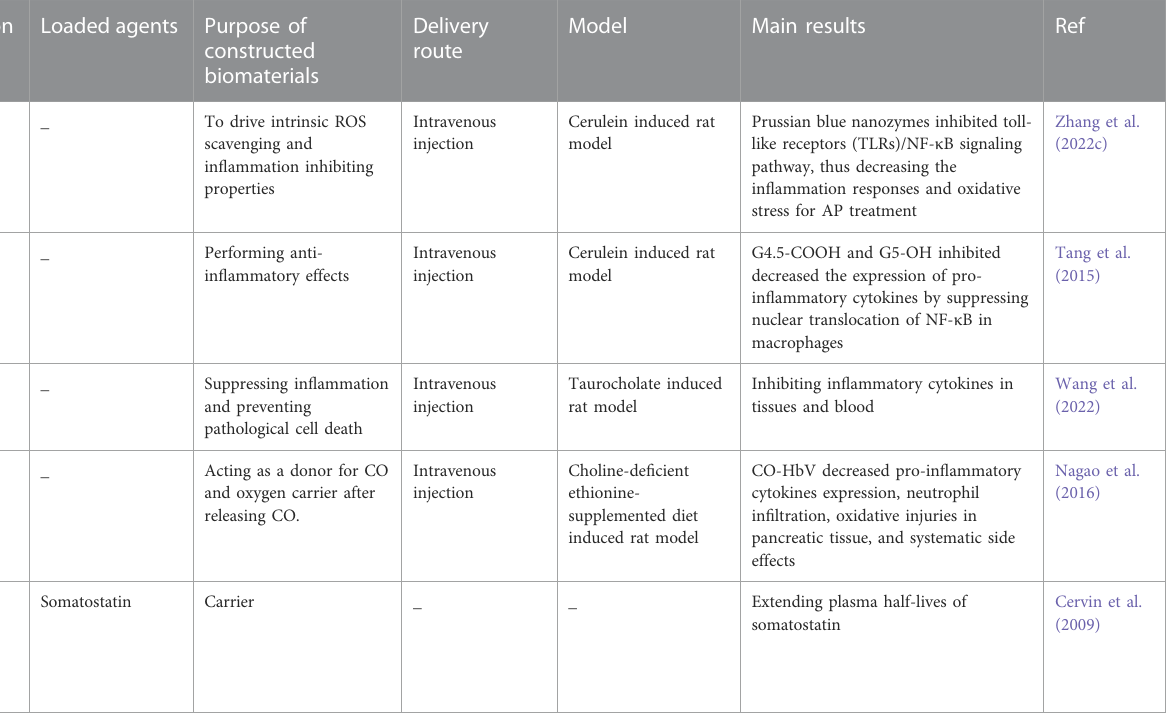
TABLE 1 ( Continued ) The targeting and functional effects of biomaterials constructed for nanoagents for AP